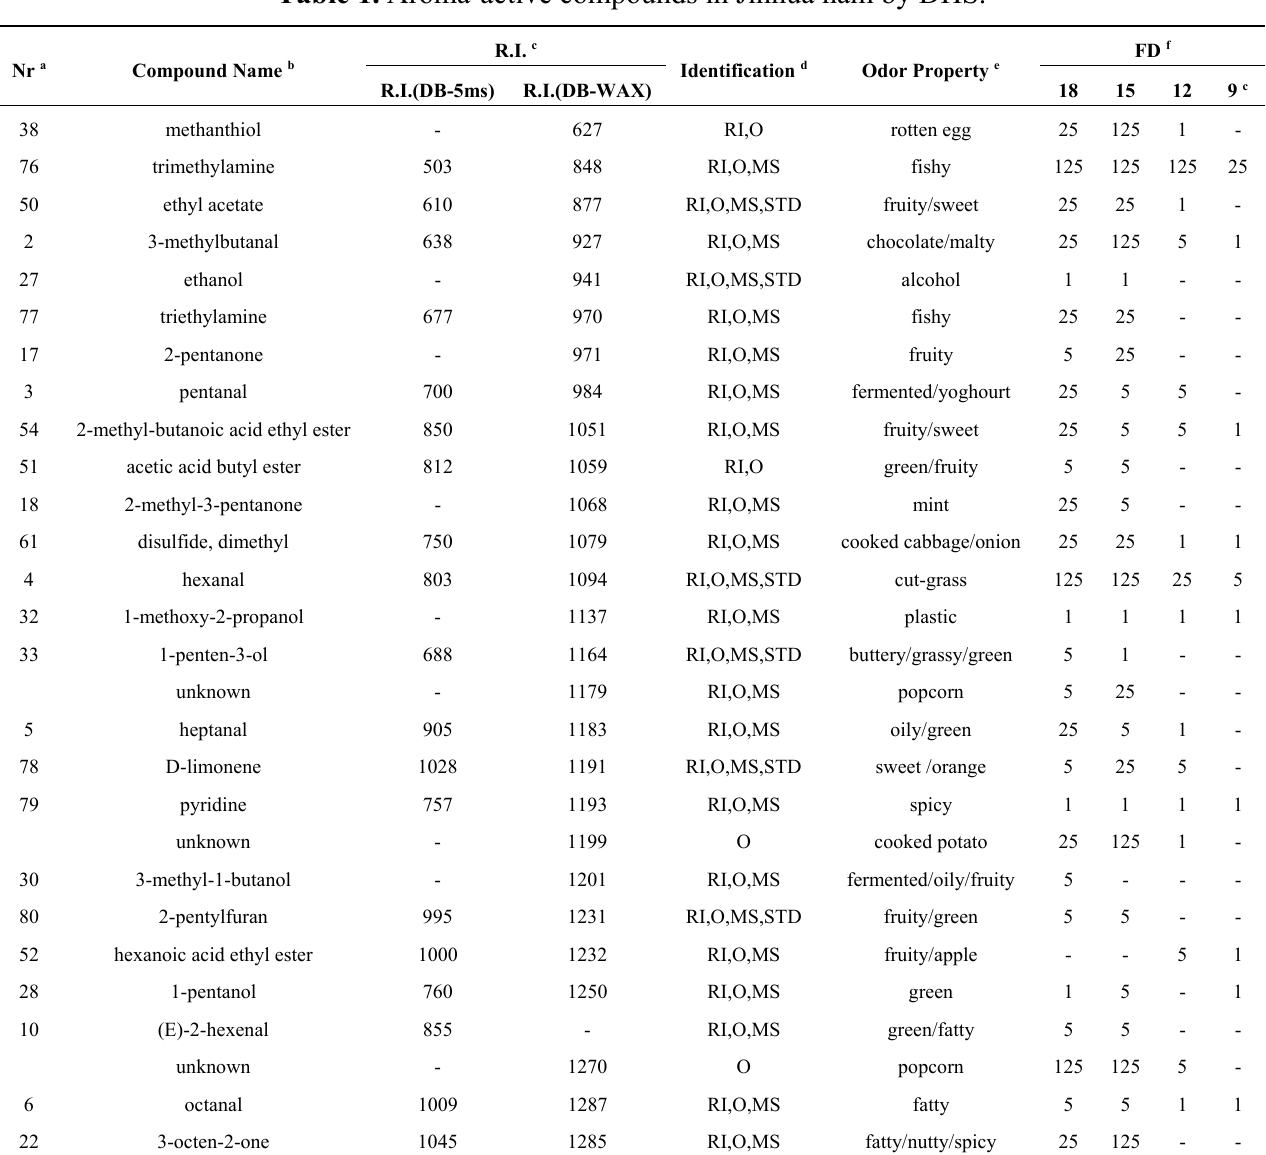
Table 1. Aroma-active compounds in Jinhua ham by